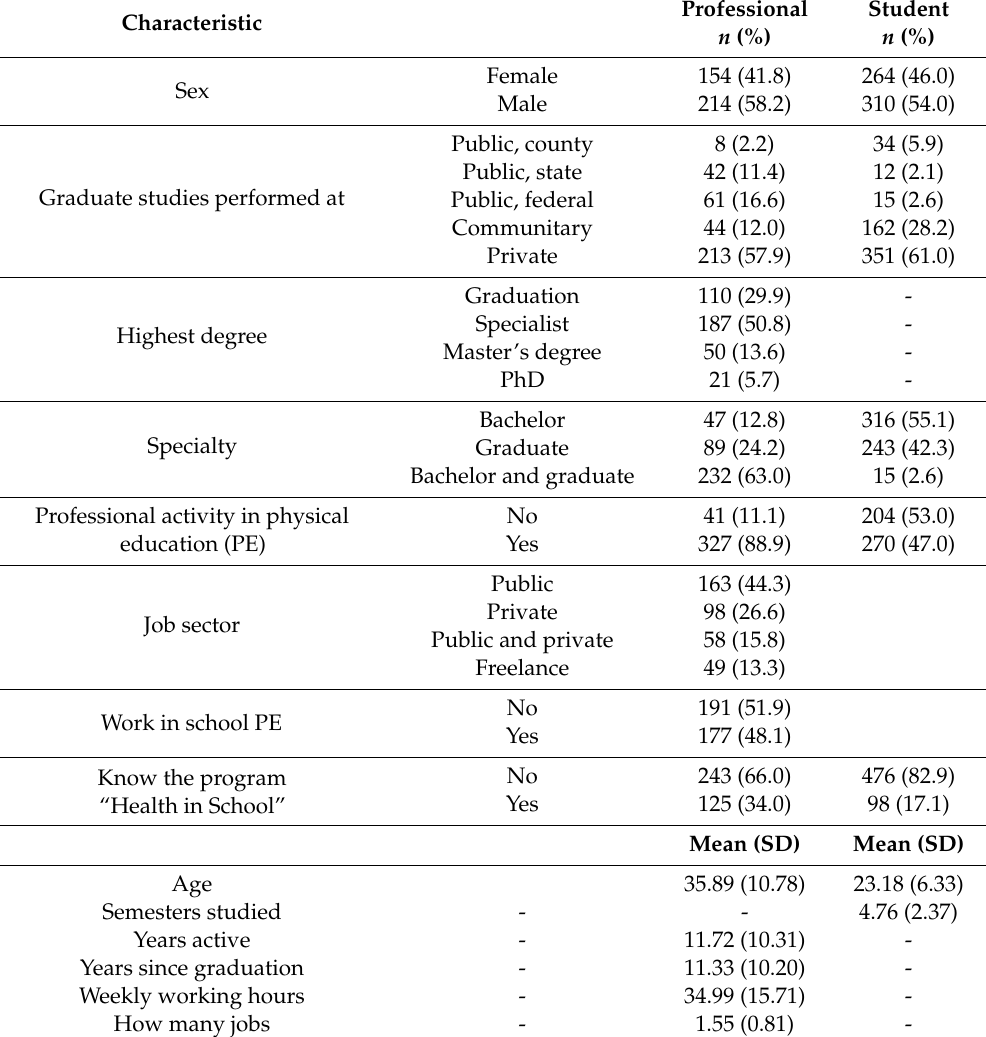
Table 1. Sociodemographic characteristic of the